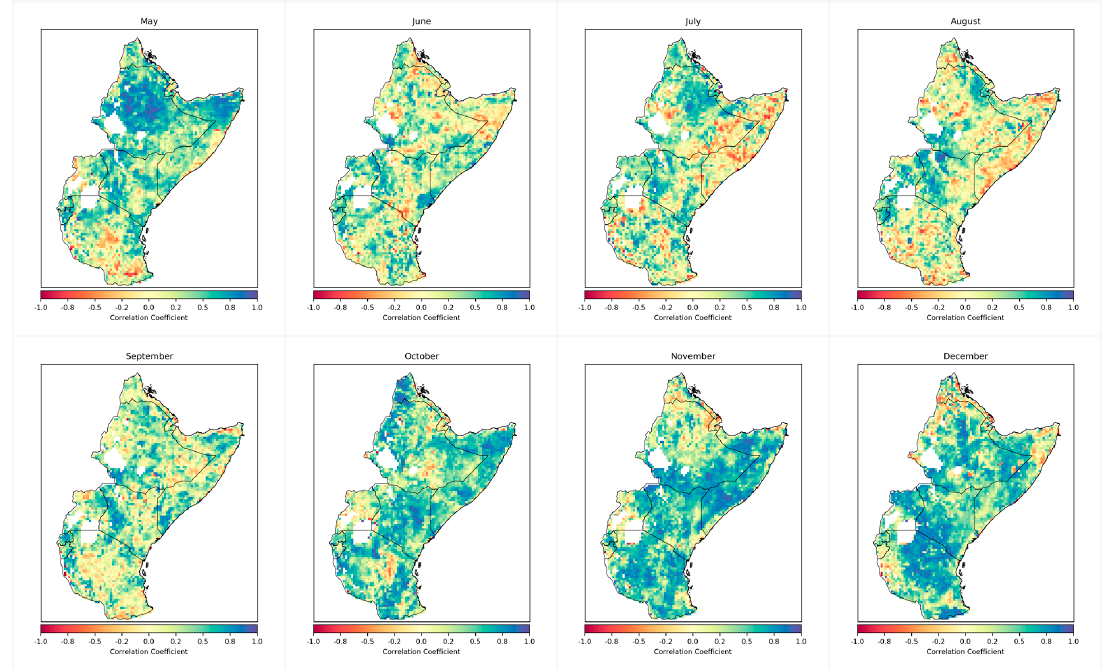
Figure A3. Pearson correlation coefficient for monthly CHIRPS and ESA CCI soil moisture (2003–2016).